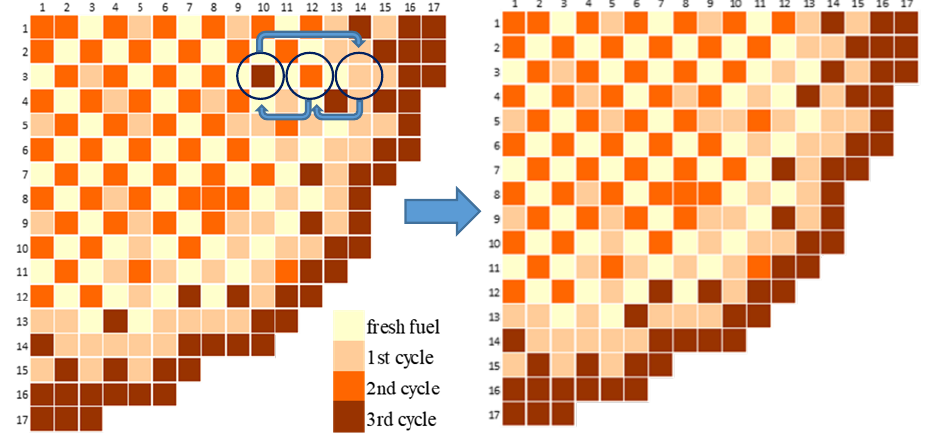
Figure 7. BWR full core layout adjustment.